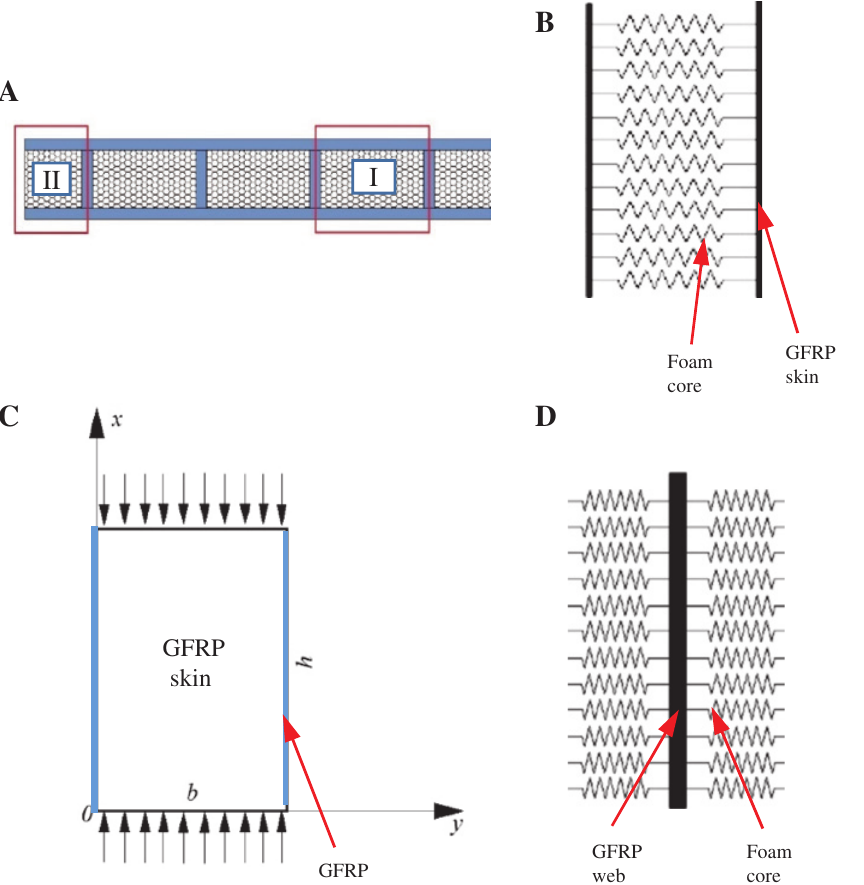
Figure 12: Analytical model (A) closed web-foam core element (Part I) and unclosed web-foam core element (Part II), (B) elastic foundation model for skin, (C) local buckling calculation of skin element, and (D) elastic foundation model for